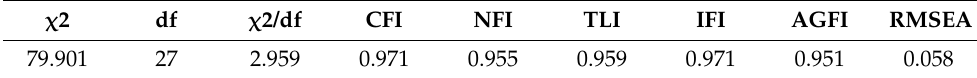
Table 8. Fit indices of the hypothesis model.